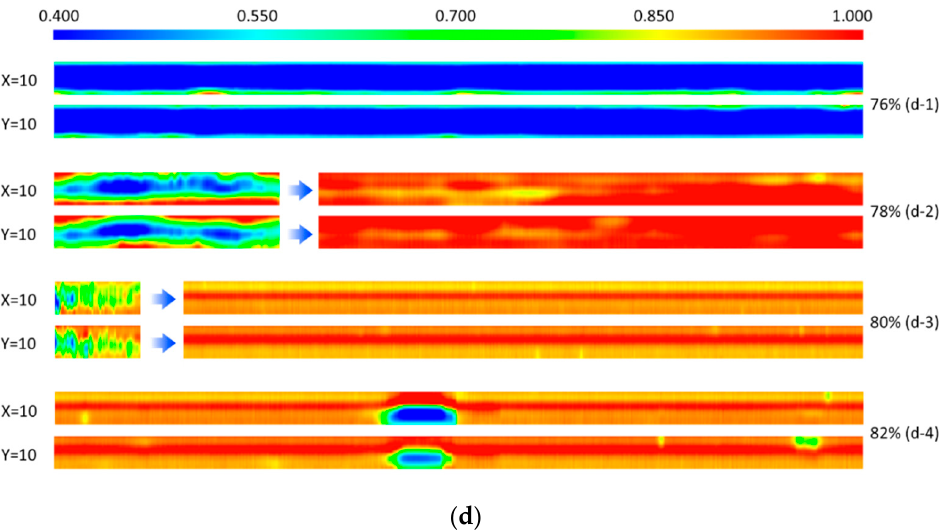
Figure 8. Flow patterns from ERT for paste slurry flowing in vertical pipes. ( a ) S1-Zone 1; ( b ) S1-Zone 2; ( c ) S2-Zone 1; and ( d ) S2-Zone 2.